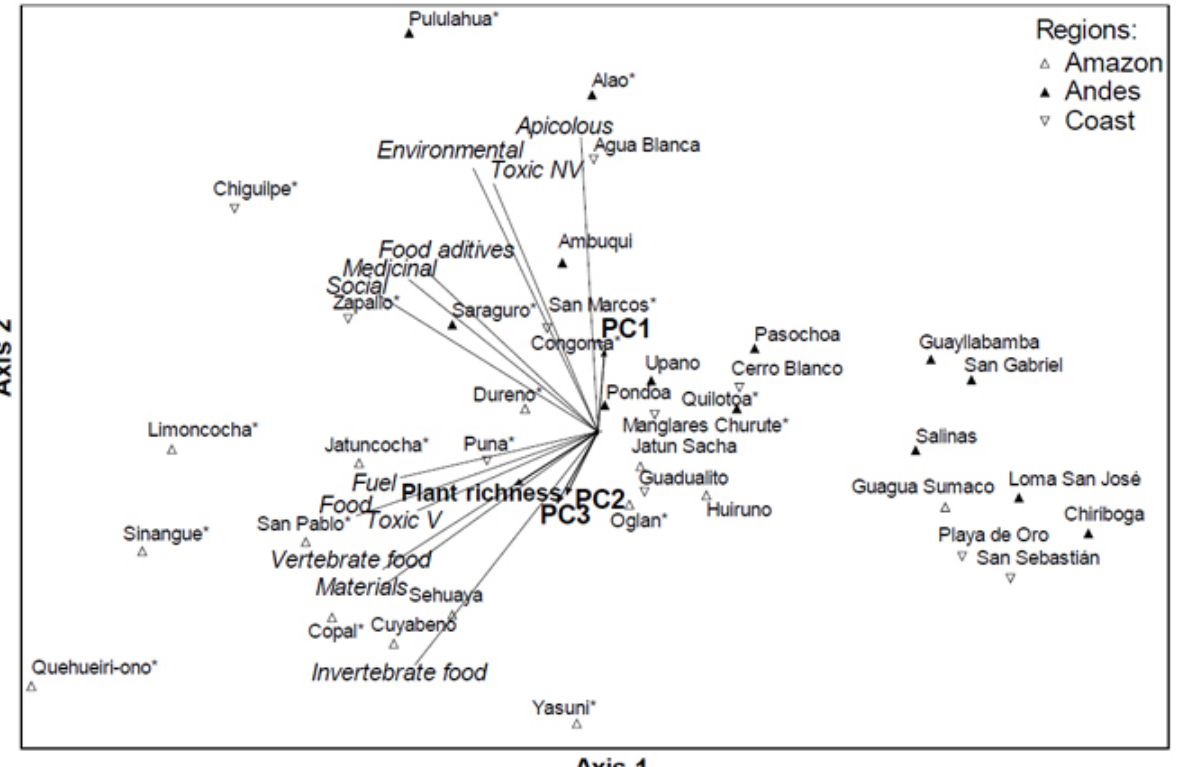
Fig. 2. Biplot of the PCA ordination performed for the plant use patterns (distribution of use records on use categories) of 38 Ecuadorian